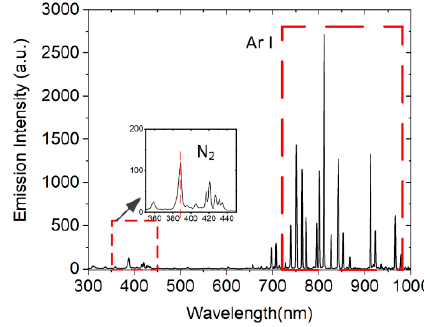
Figure 8. The spectrum of the coaxial line plasma driven by 800 W microwave at the pressure of 80 Pa.